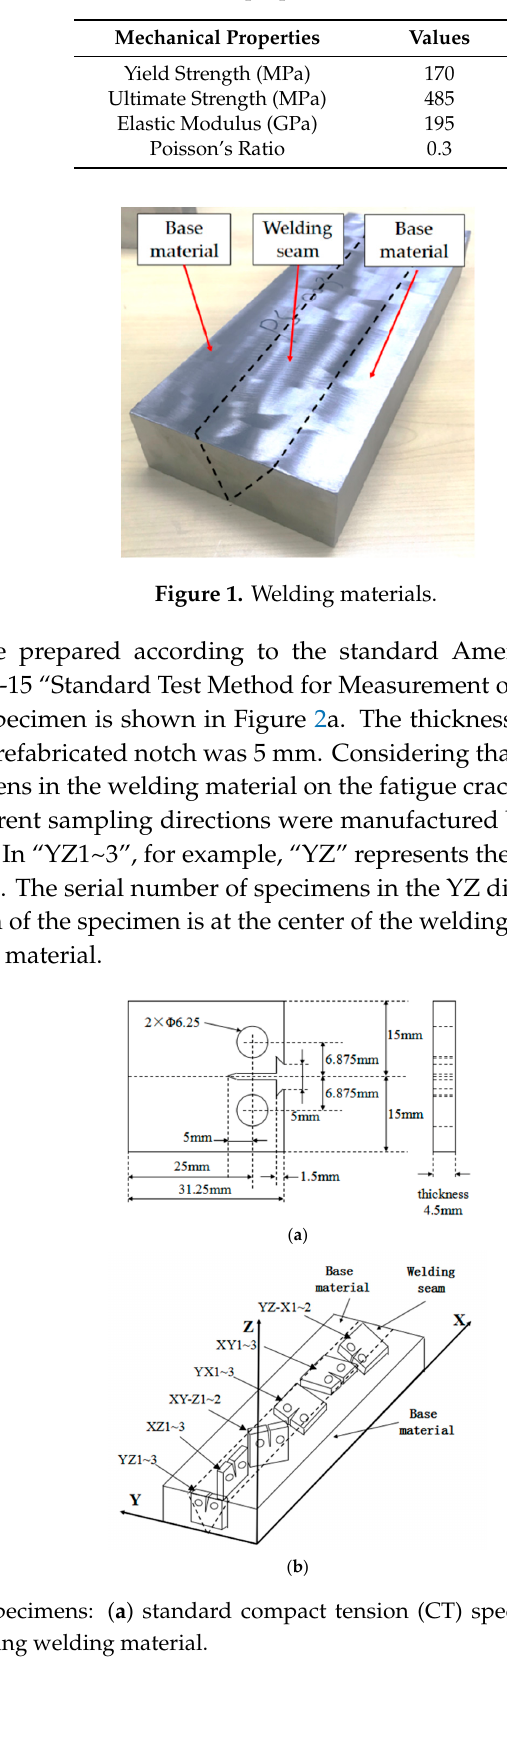
Figure 2. Size of specimens: ( a ) standard compact tension (CT) specimen; ( b ) 16 CT specimens manufactured by using welding material.